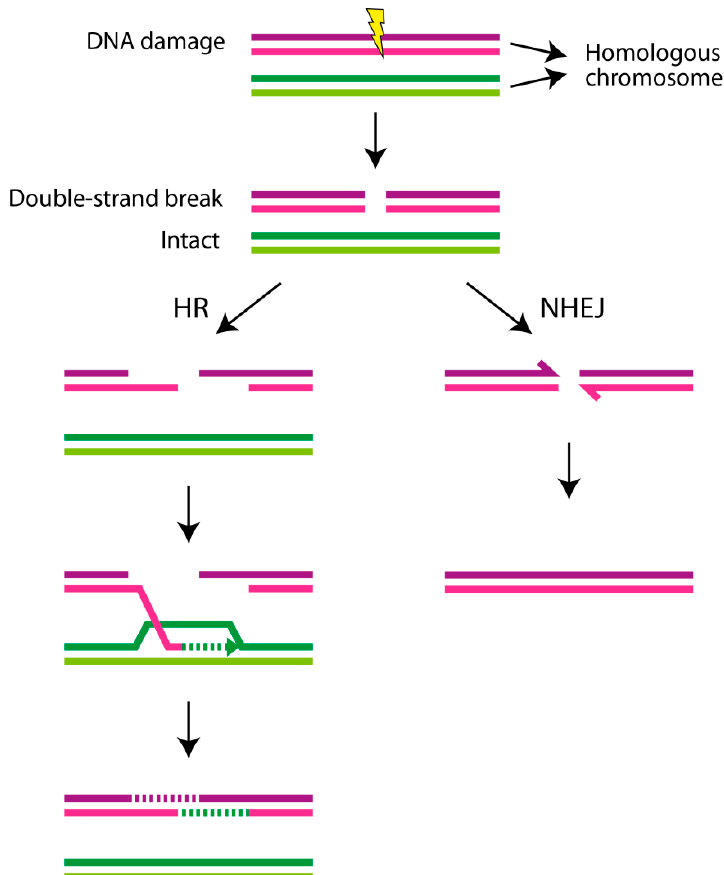
Figure 2. Double-strand breaks (DSBs) and repair mechanisms. Genotoxic factors, such as ionizing radiation, reactive oxygen species, and toxic environmental chemicals lead to DNA damage, which is different from a mutation occurring during DNA replication. Of the different types of DNA lesions, double-strand breakage is the most deleterious form of DNA damage. DSBs are repaired through different DNA repair pathways. Two main forms of DSB repair are homologous recombination (HR), which is an error-free DNA repair, and nonhomologous end joining (NHEJ), which is an error-prone DNA repair. When DSBs are unrepaired, e.g., in HR-mediated DNA repair disorders as described in the text, this leads to cellular transformation, senescence, and/or cell death.